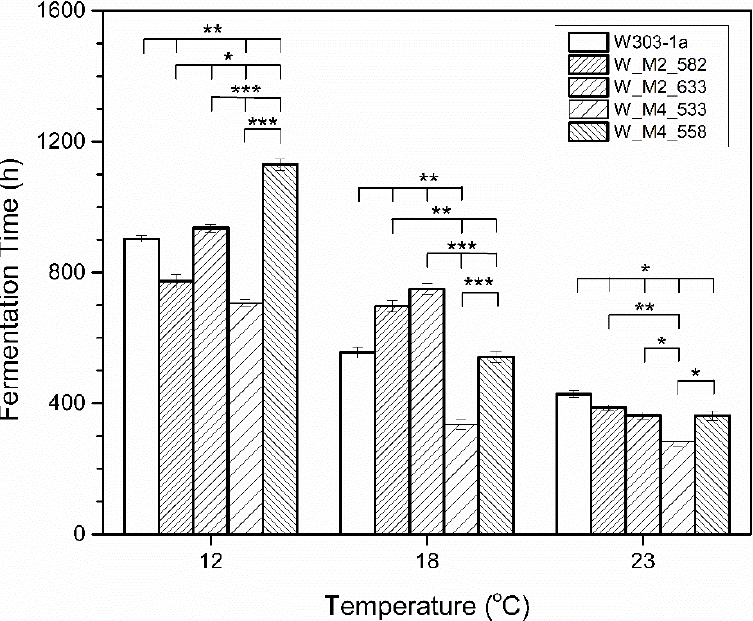
Figure 2. Total fermentation time (h) at several temperatures. Statistically significant differences were designated with asterisks (* p < 0.05, ** p < 0.01, *** p <